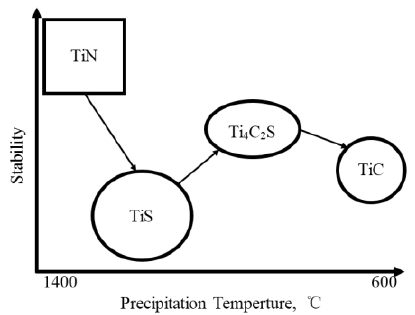
Figure 5. Schematic illustration of the stability of various Ti compounds in Interstitial-Free (IF) steels as a function of the precipitation temperature.